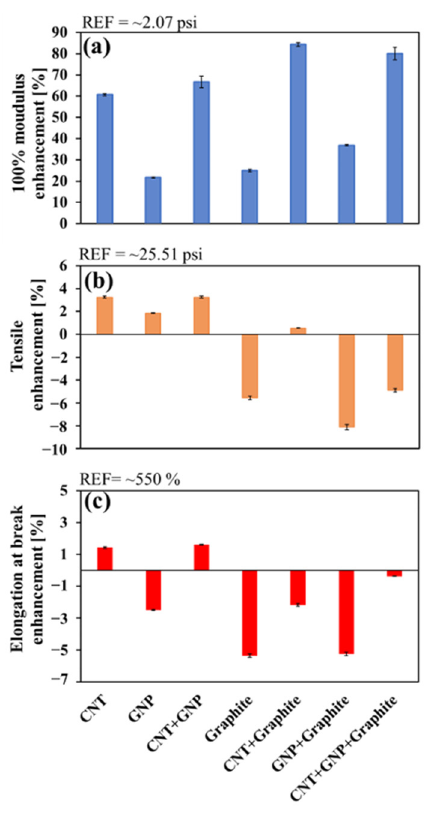
Figure 4. Mechanical properties enhancement of the various systems: ( a ) 100% modulus (blue), ( b ) tensile strength (orange), and ( c ) elongation at break (red). The measured values and their errors are detailed in Table S1.